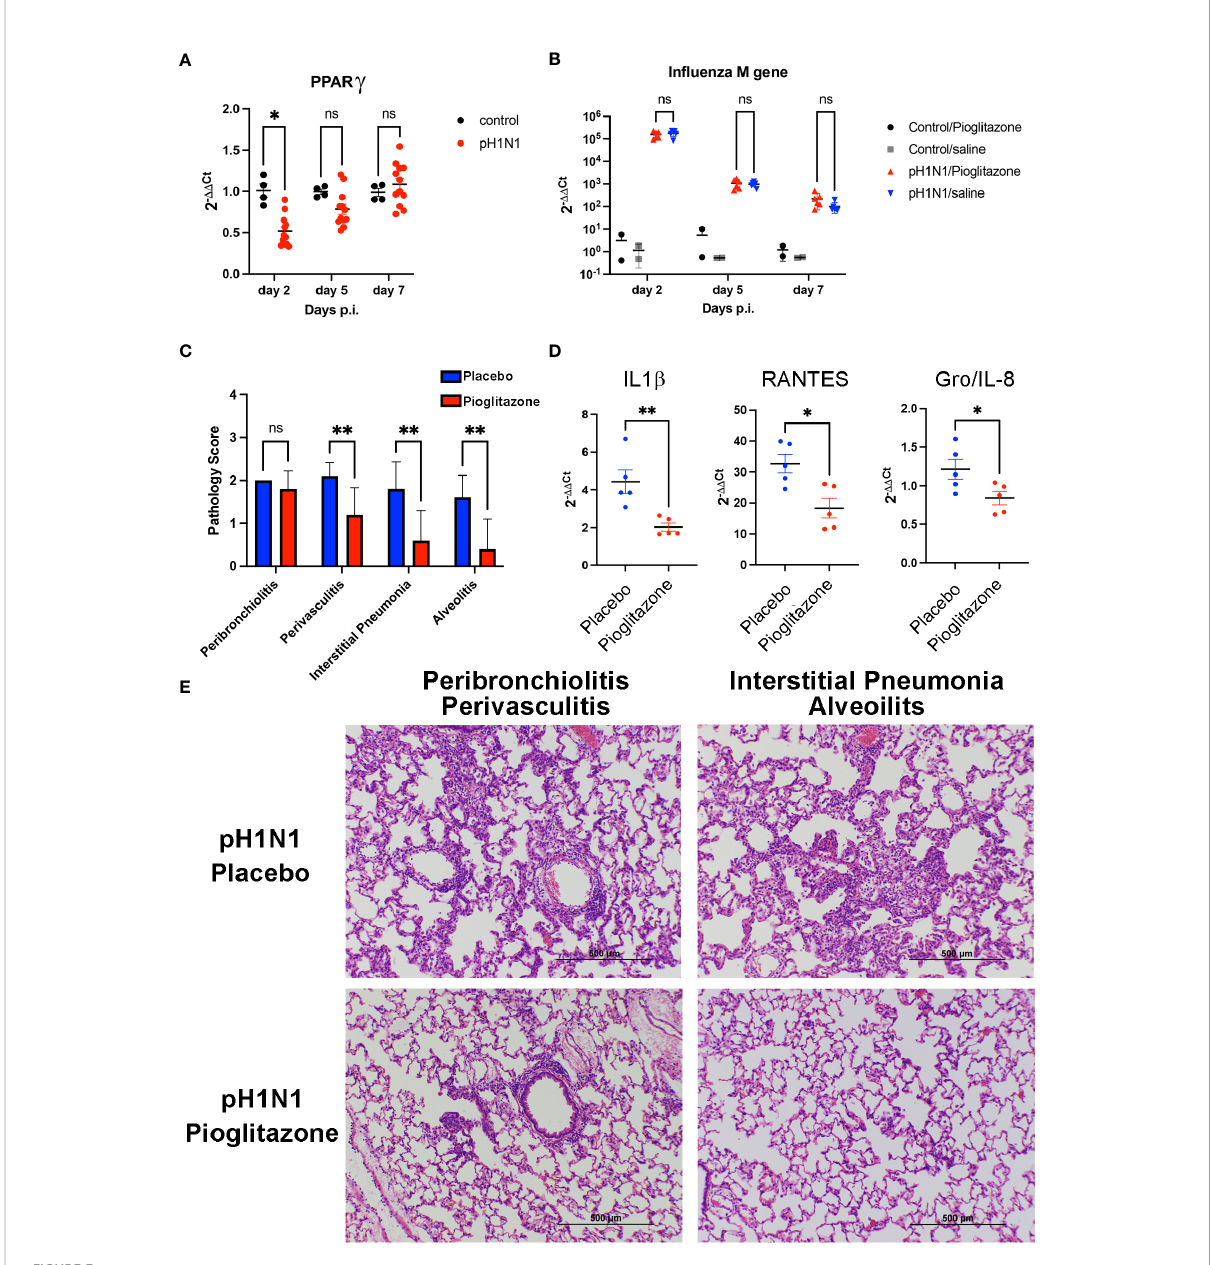
FIGURE 3 Pioglitazone treatment reduces pH1N1-induced lung pathology and in fl ammation without altering viral replication in cotton rats. (A) Expression of PPAR g mRNA in cotton rat lungs after pH1N1 (A/California/04/2009) in fl uenza infection. *, p<0.05 by ANOVA (n = 4-10 cotton rats/time point). ns, not signi fi cant. (B – E) . Cotton rats infected with pH1N1 were treated daily starting 24 h after challenge with vehicle (Placebo) or 3 mg/ kg of pioglitazone, i.p. until the day prior to sacri fi ce (day 4 or day 6 p.i). (B) Treatment with pioglitazone does not affect the kinetics of viral replication as measured by in fl uenza M gene expression. ns, not signi fi cant. (C – E) . Cotton rats were euthanized on day 5 to determine lung pathology and expression of mRNA encoding in fl ammatory cytokines. (C) Pathology scores for the indicated features. **, p<0.01 by ANOVA followed by Sidak ’ s multiple comparisons test (n = 10 cotton rats/treatment group). ns, not signi fi cant. (D) qRT-PCR measurements for expression of IL-1 b , RANTES, and Gro/IL-8 mRNA in lungs of infected and treated animals, as indicated. * and **, p<0.05 and p<0.01, respectively (unpaired t -test). (E) H&E-stained slides of cotton rat lungs showing representative features of pathology scored in C, i.e. , pioglitazone treatment induced a signi fi cant reduction in perivasculitis, interstitial pneumonia, and alveolitis, whereas no signi fi cant reduction in peribronchiolitis was